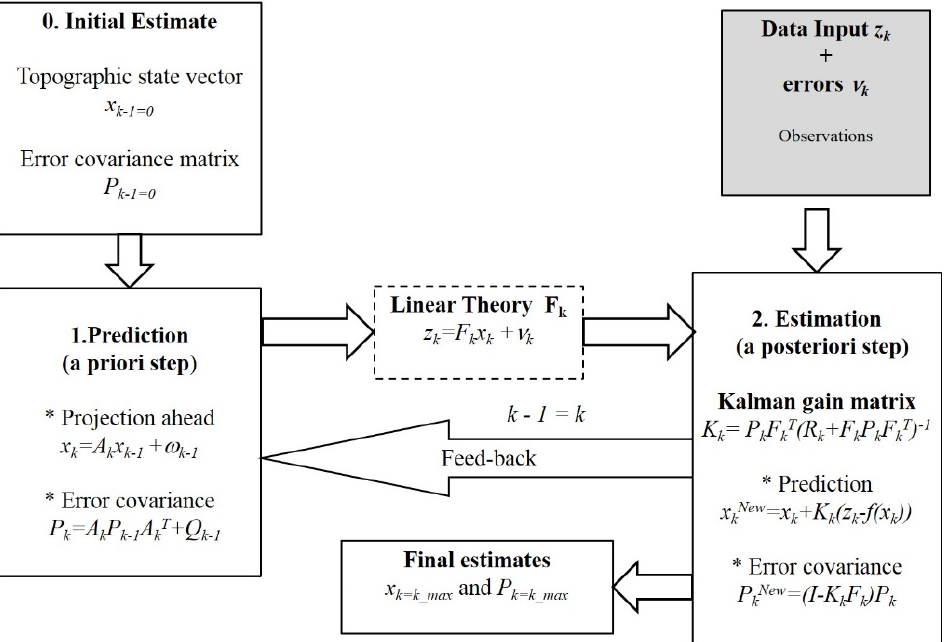
Figure 2. Flowchart of the Extended Kalman Filtering (EKF) procedure to estimate topographic heights from gravity data (geoid heights and free-air anomalies) .